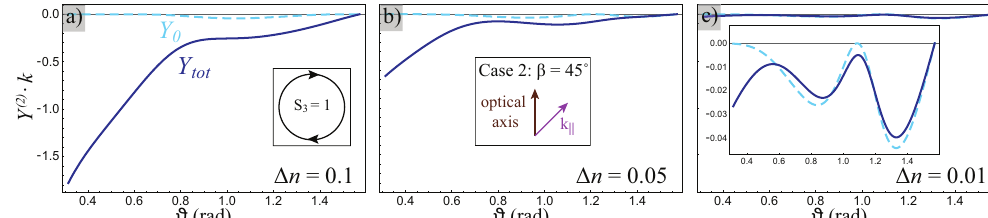
Figure 5. The dependence of the standard (cyan dashed line) and total (solid blue line) linear IF shifts on different anisotropy degrees: ( a ) ∆ n = 0.1, ( b ) ∆ n = 0.05 and ( c ) ∆ n = 0.01. We consider the case (1) in transmission configuration, the slab thickness is δ z = 2.5 λ and right-handed circular